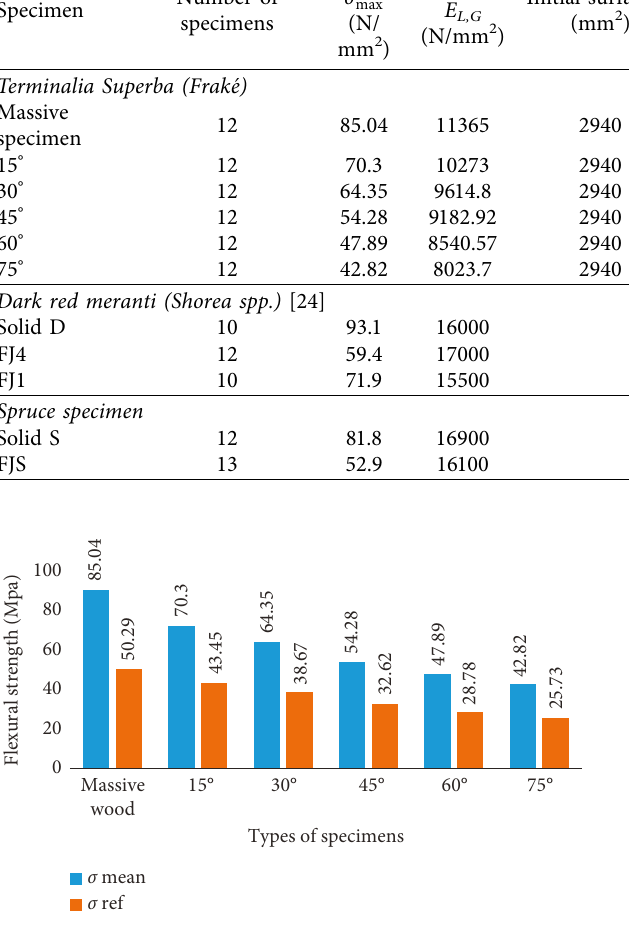
Figure 11: Comparison of bending strengths of solid and finger- jointed